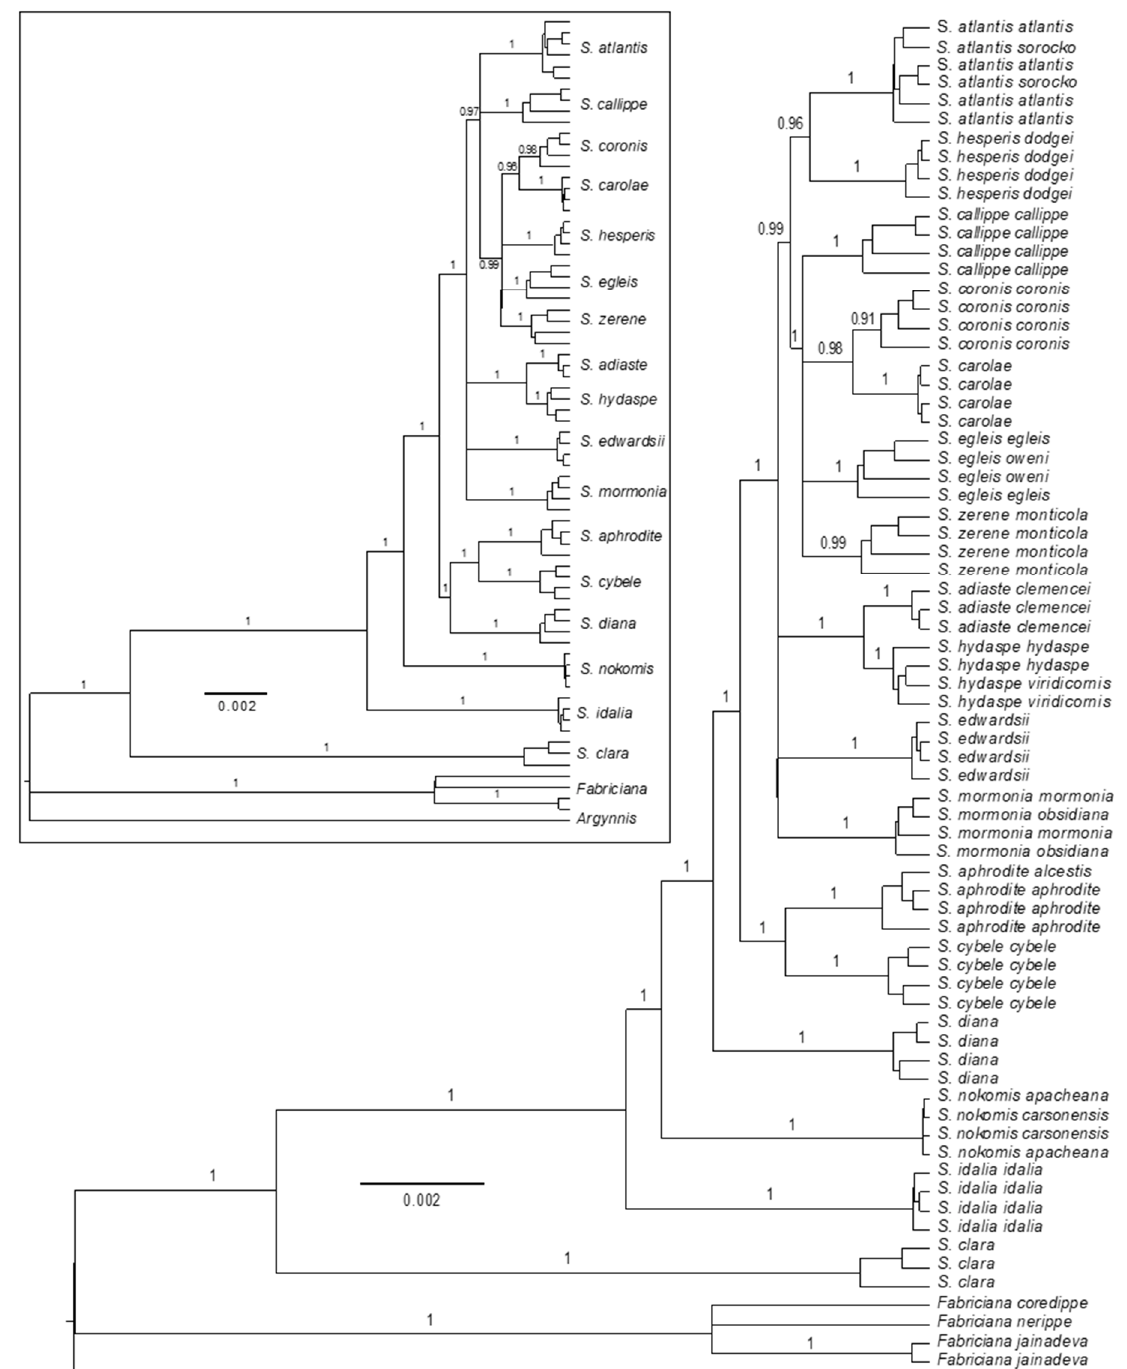
Figure 1. Phylogenomic results for analyses with parameter rich locus-specific substitution models and HKY (inset) for all 50 loci. Posterior values are omitted within species and branches are collapsed for interspecies nodes with <0.95, except for S. coronis in the parameterized tree.